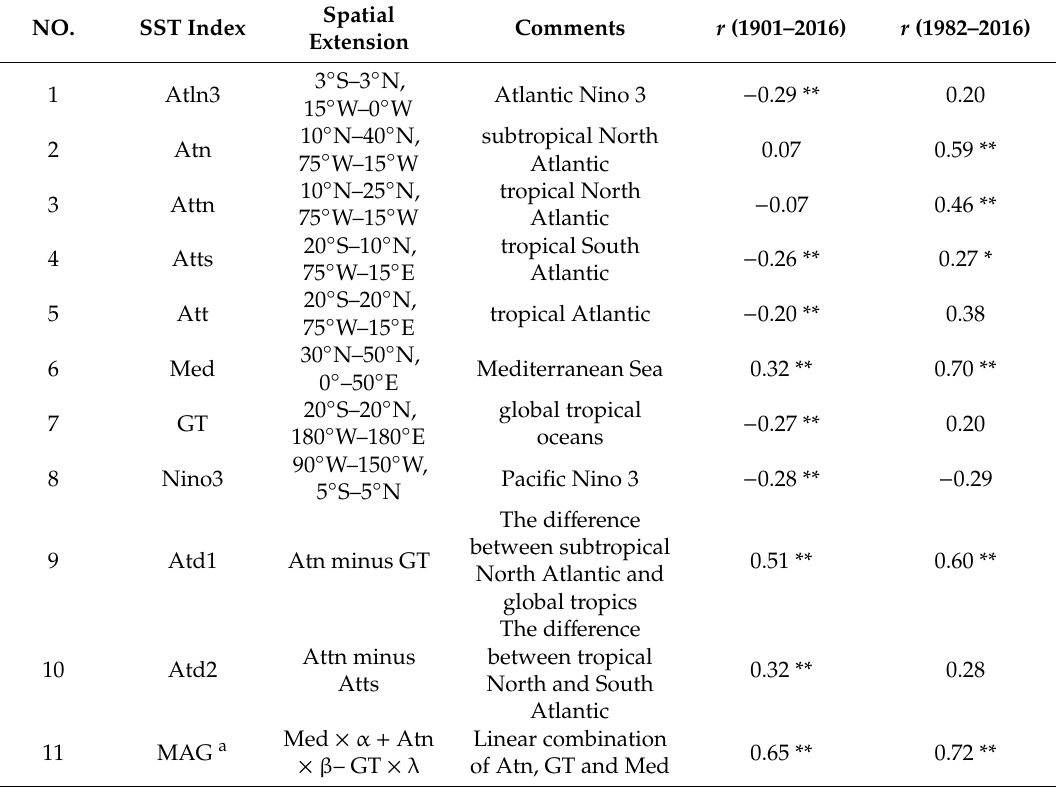
Table 1. List of sea surface temperature (SST) indices evaluated in this paper and interannual correlations (r) between these indices and the Sahelian precipitation averaged over May to October (M–O) between 1901 and 2016, including the one proposed in this study—a linear combination of the Mediterranean Sea, the subtropical North Atlantic, and the global tropical